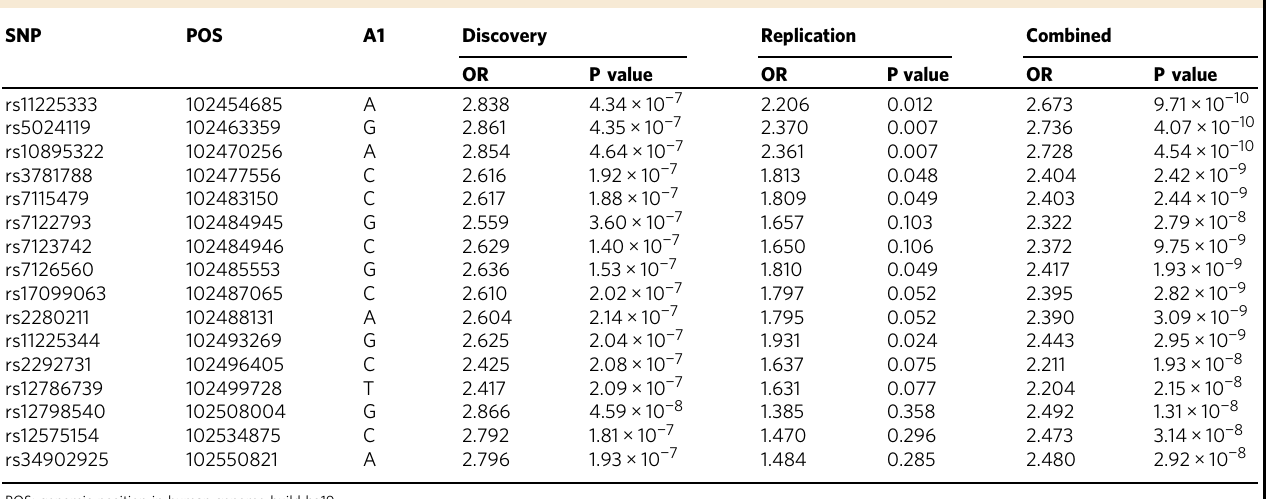
Table 3 Imputed SNPs surpassing genome-wide signi fi cance within and near